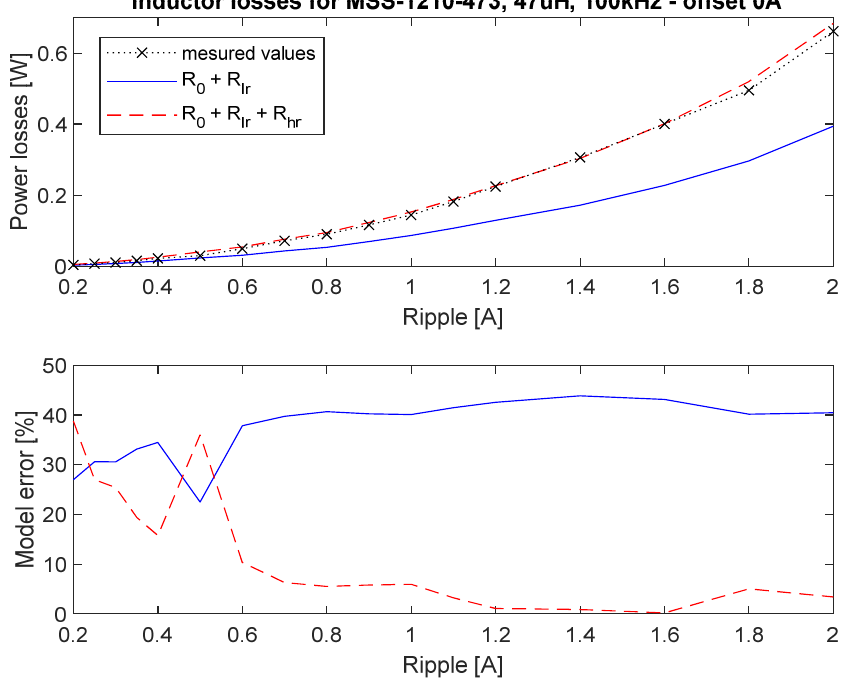
Figure 9. Evolution of losses into an MSS1210-473 47 µH inductor at 100 kHz over a ripple current magnitude from 0.2 up to 2 A. The upper curve represents the losses into the inductor measured and calculated with models of Equation (4) in blue and (6) in red. The bottom curves present the absolute relative errors between the impedance analyser model and the AC loss model.